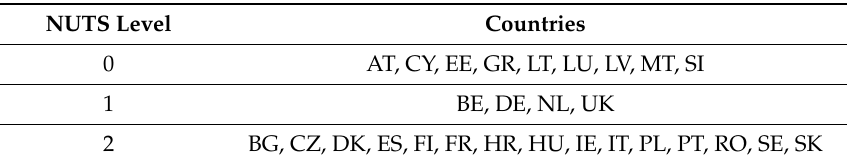
Table 1. NUTS-levels for